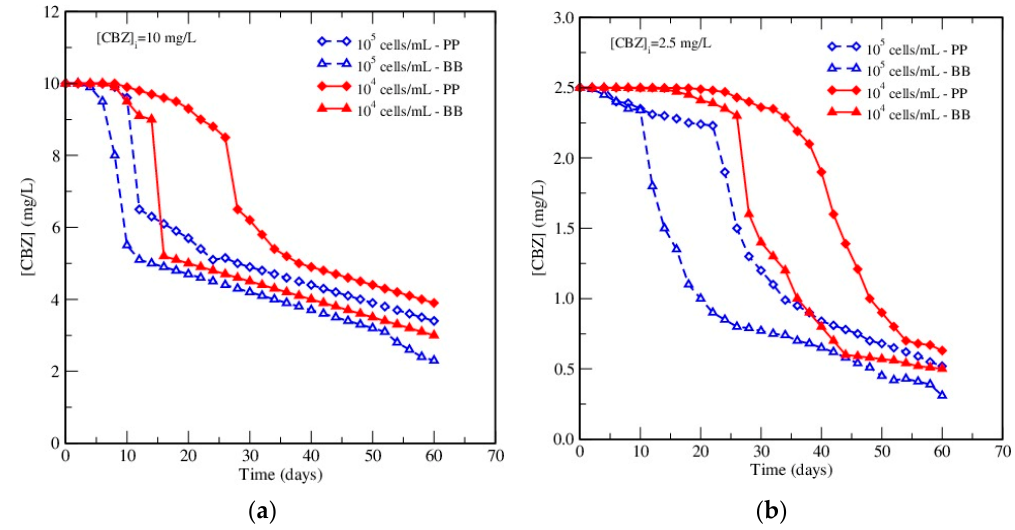
Figure 3. Effect of inoculum concentration on the removal of CBZ in both media at: ( a ) 10 mg/L, and ( b ) 2.5 mg/L of CBZ.